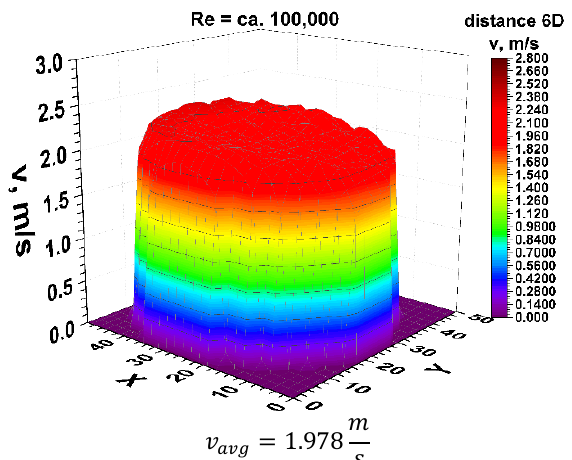
Figure 12. Velocity block at the distance 6D from the disturbance obtained by means of LDA measurements for Re ≅ 100,000.